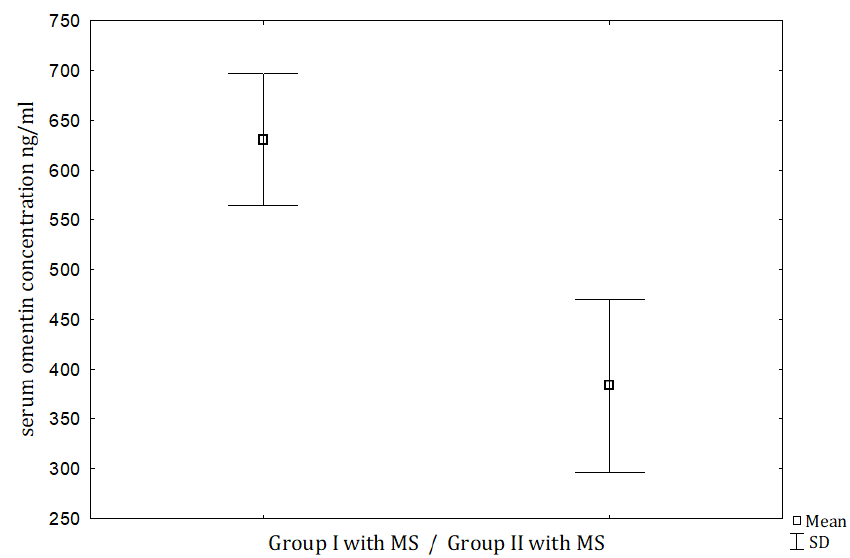
Figure 1. Comparison of serum omentin between men with PC (Group 1) and metabolic syndrome versus men with BPH (Group 2) and metabolic syndrome. p < 0.001. PC, prostate cancer; BPH, benign prostate hyperplasia; MS, metabolic syndrome; SD, standard deviation.